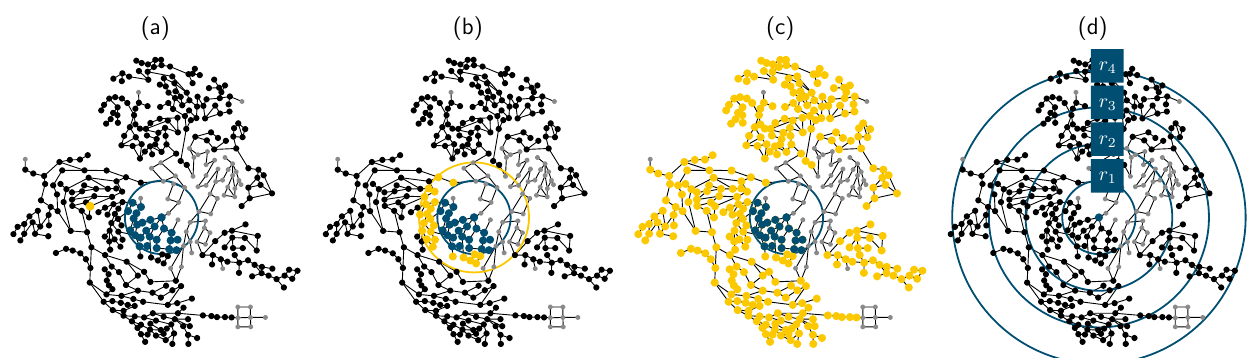
Figure 1. An overview of sheltering schemes ( a – c ) and a comparative depiction of the evacuation radii ( d ). Nodes in the evacuated area ( E ) are portrayed in blue, shelter nodes are portrayed in yellow. Consumer nodes (black) are differentiated from non-consumer nodes (grey). ( a ) centralized sheltering scheme, ( b ) near-at-hand sheltering scheme, ( c ) diffuse sheltering